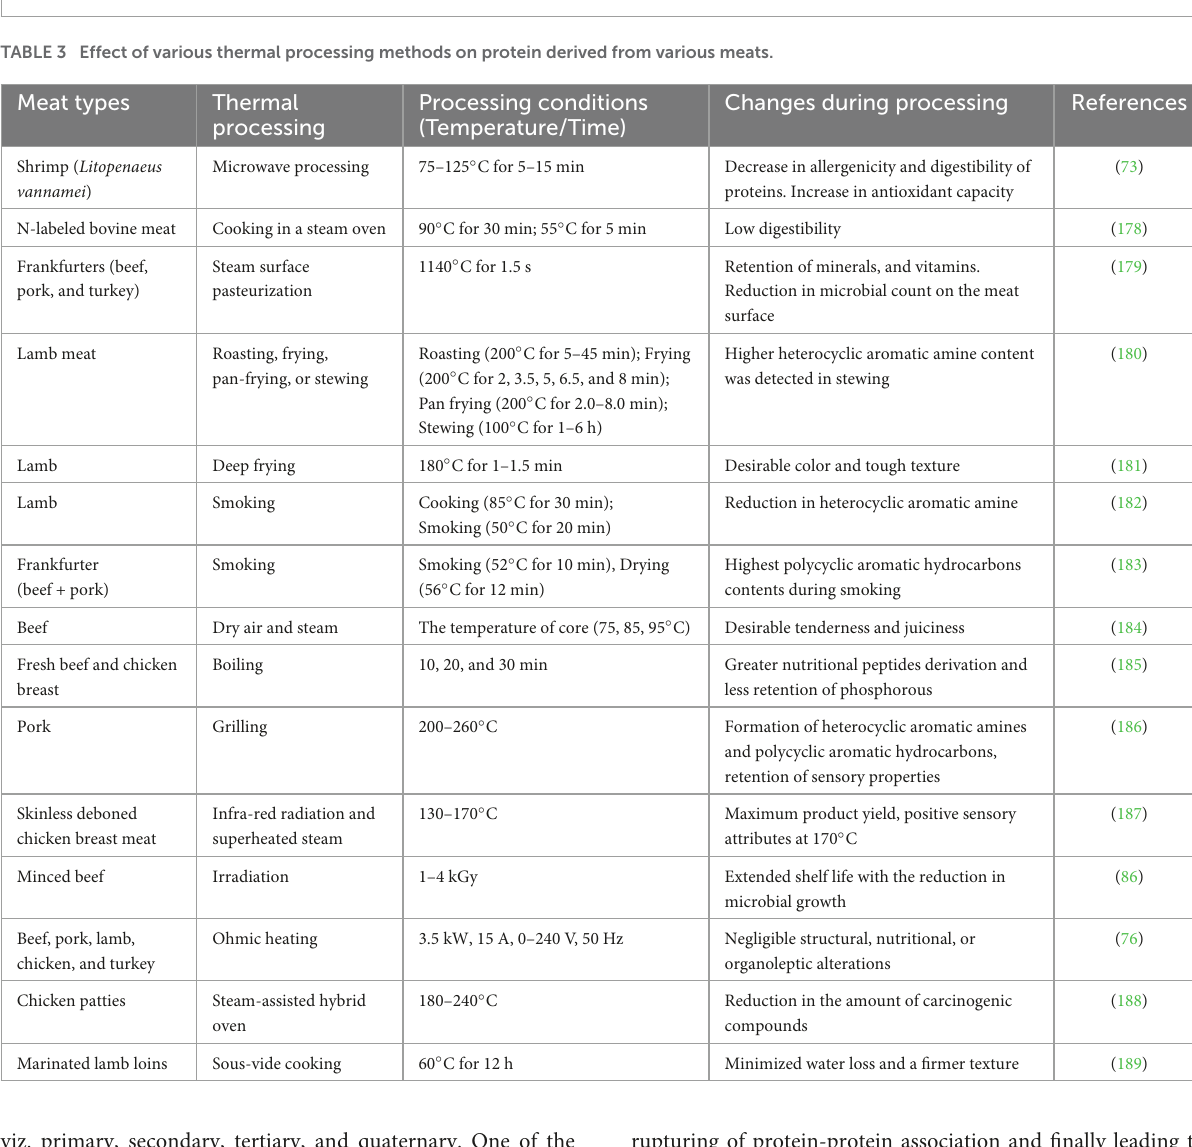
FIGURE3 Oxidative changes after thermal processing.